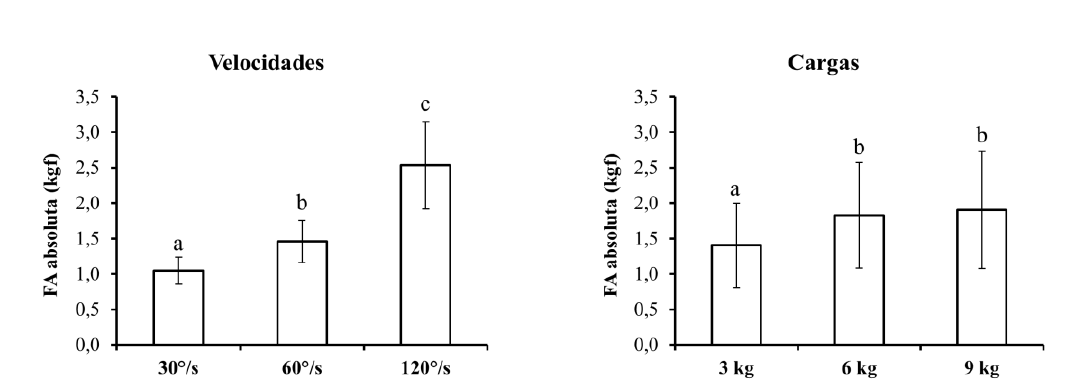
Figura 5. Resultados da comparação da força de atrito durante as três velocidades e três cargas, em valores absolutos. Letras diferentes indicam diferenças estatisticamente significativas